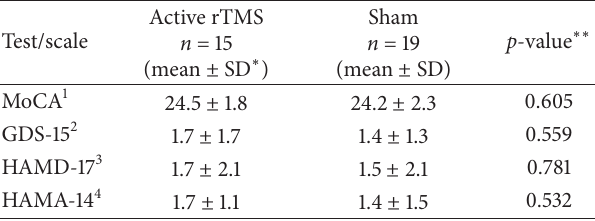
Table 4: Subjects screening: part